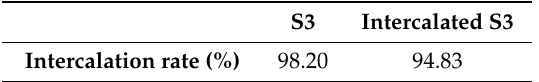
Table 1. The intercalation rate using di ff erent raw materials.